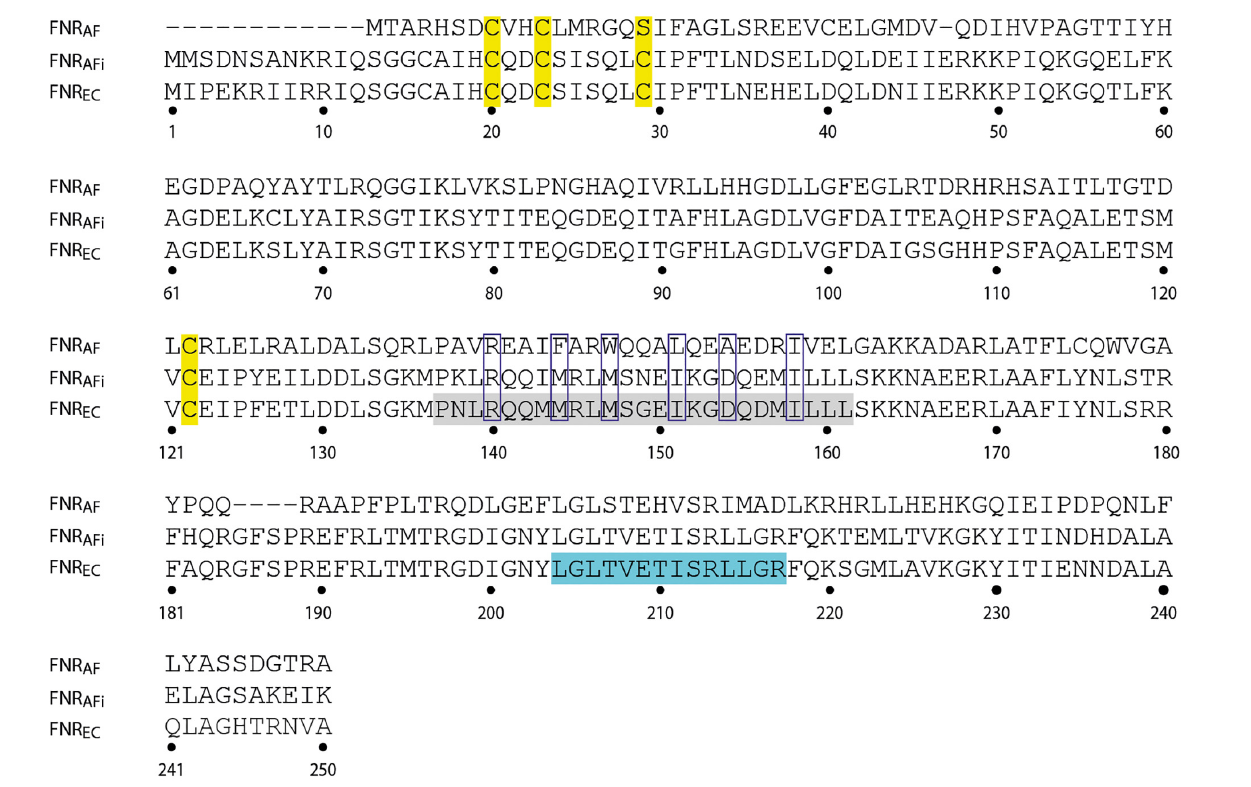
FIGURE 7 | Comparison of the amino acid sequence of FNR AF (AFE_0270) with that of FNR EC (WP_000916335). The sequence of FNR from Aliivibrio fisheri (FNR AFi ; Q5E593) is included for comparison. The numbers correspond to the amino acid sequence of FNR EC . In the sequence of FNR EC , the four cysteines coordinating the [4Fe-4S] 2 + center are highlighted in yellow. FNR EC sequences corresponding to the dimerization helix and the DNA binding HTH motif are highlighted in gray and turquoise, respectively. Clear boxes indicate additional amino acids discussed in the